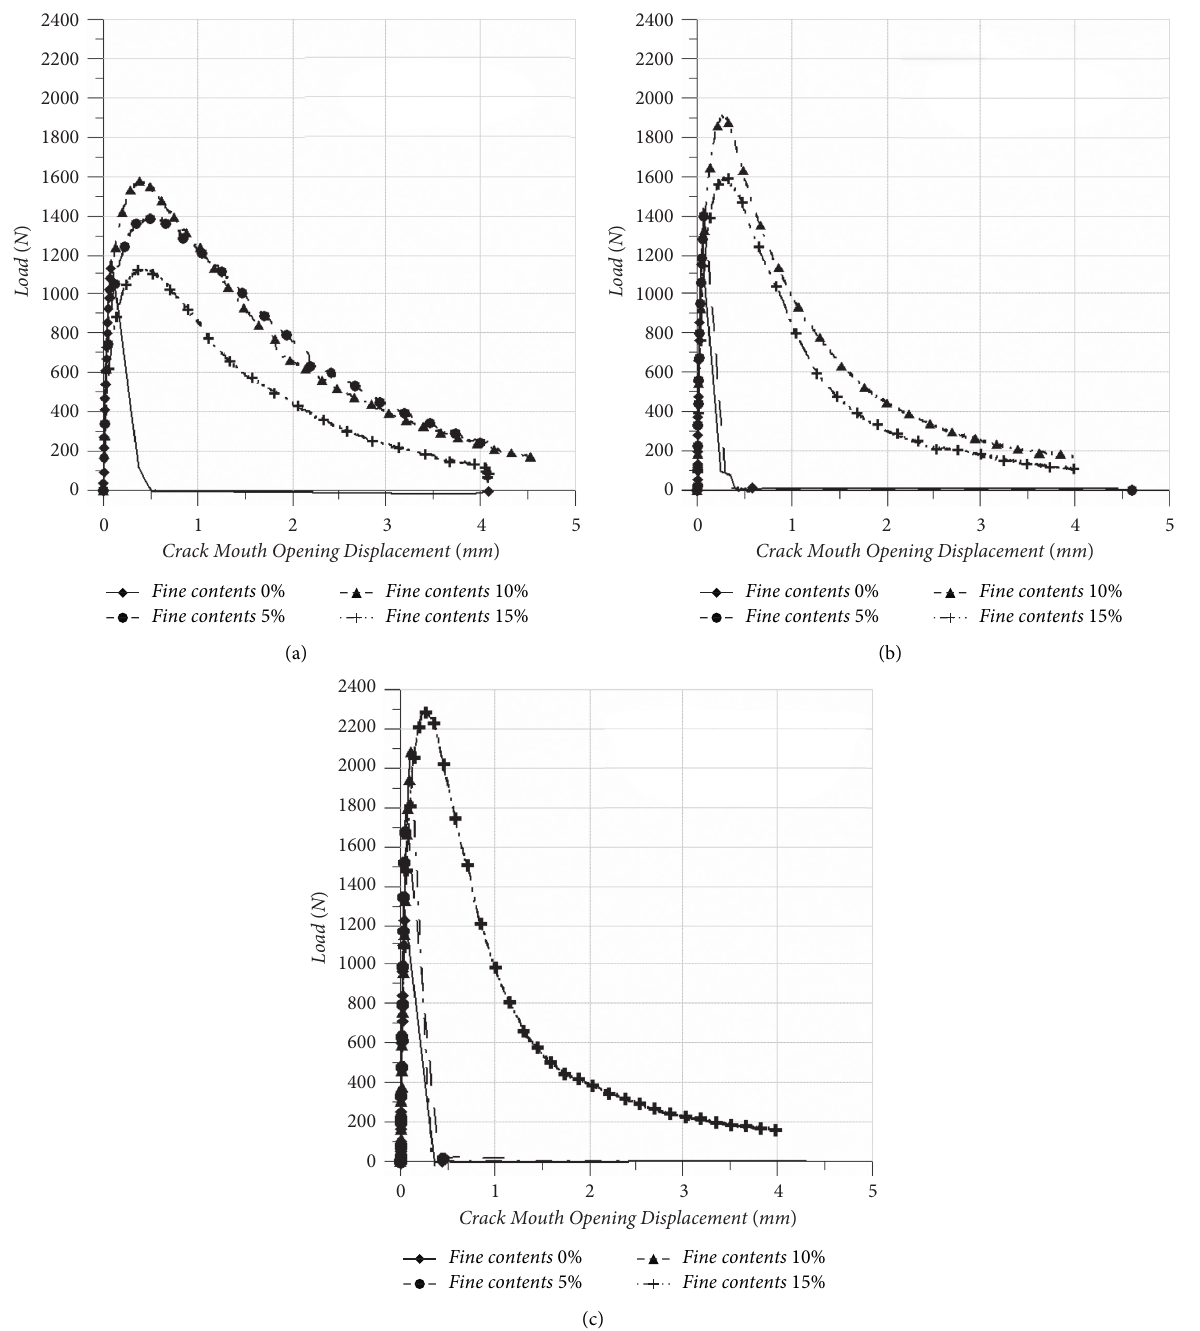
Figure 11: K Ic test results of the frozen sand at